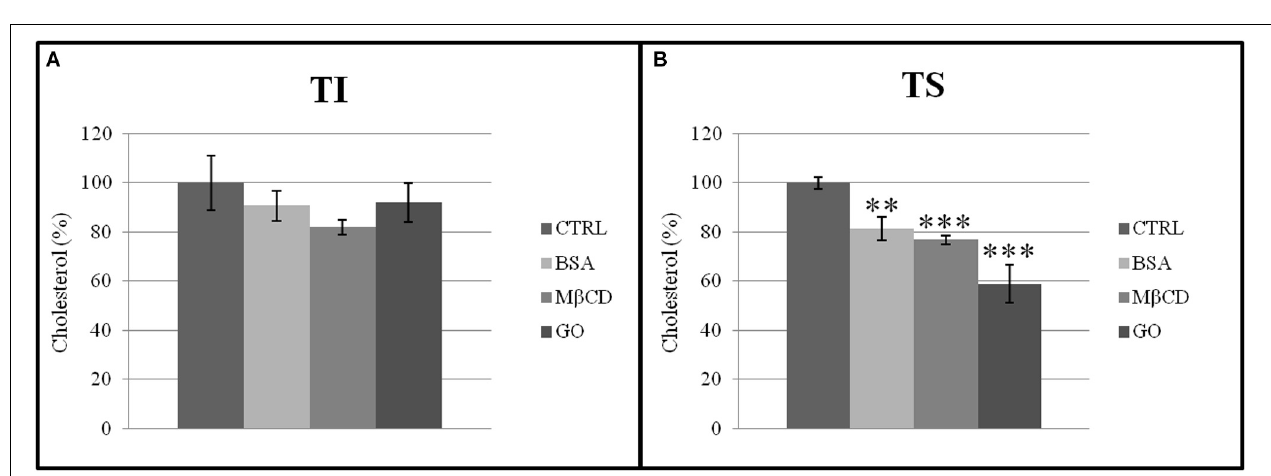
FIGURE 7 | Cholesterol/Phospholipids ratio in (A) insoluble (TI) and (B) soluble (TS) membrane fractions, isolated from MEF prepared from sperm incubated in a capacitating medium (BSA, M β CD, GO treatments) or from sperm collected in a non-capacitating medium (CTRL). Values are means ± SE for three separate experiments. *** p < 0.001 versus control.